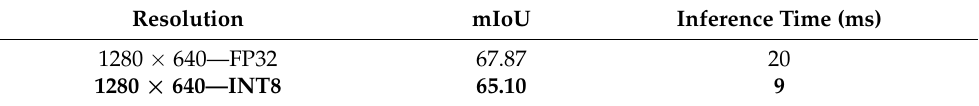
Table 1. Evaluation of the semantic segmentation network on area-view images corresponding to front, left, back, right views. 1280 × 640—INT8 (in bold) is integrated in the final solution.